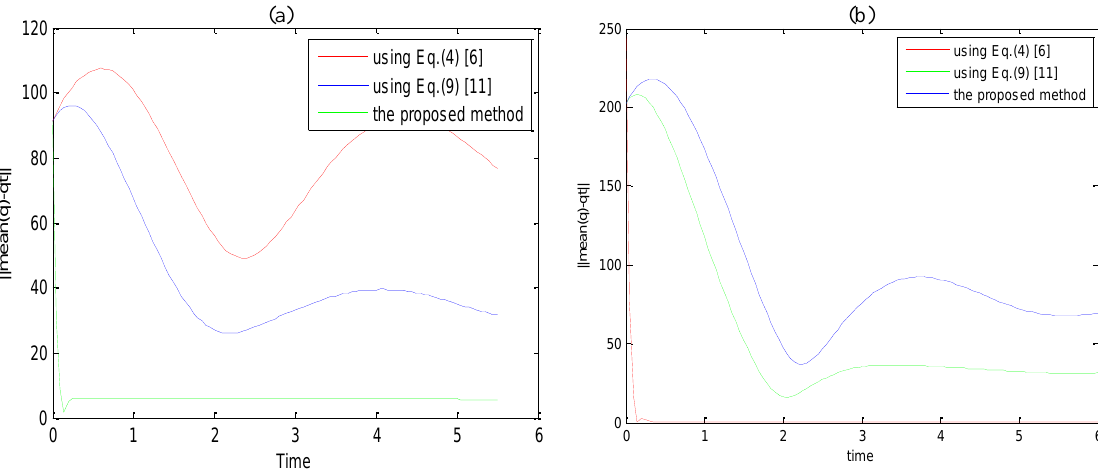
Figure 7. (a) Value of cost function during 100 iteration for 50 sensors, (b) errors between COM of locations of robots and location of target during 100 iterationa for 50 sensors.